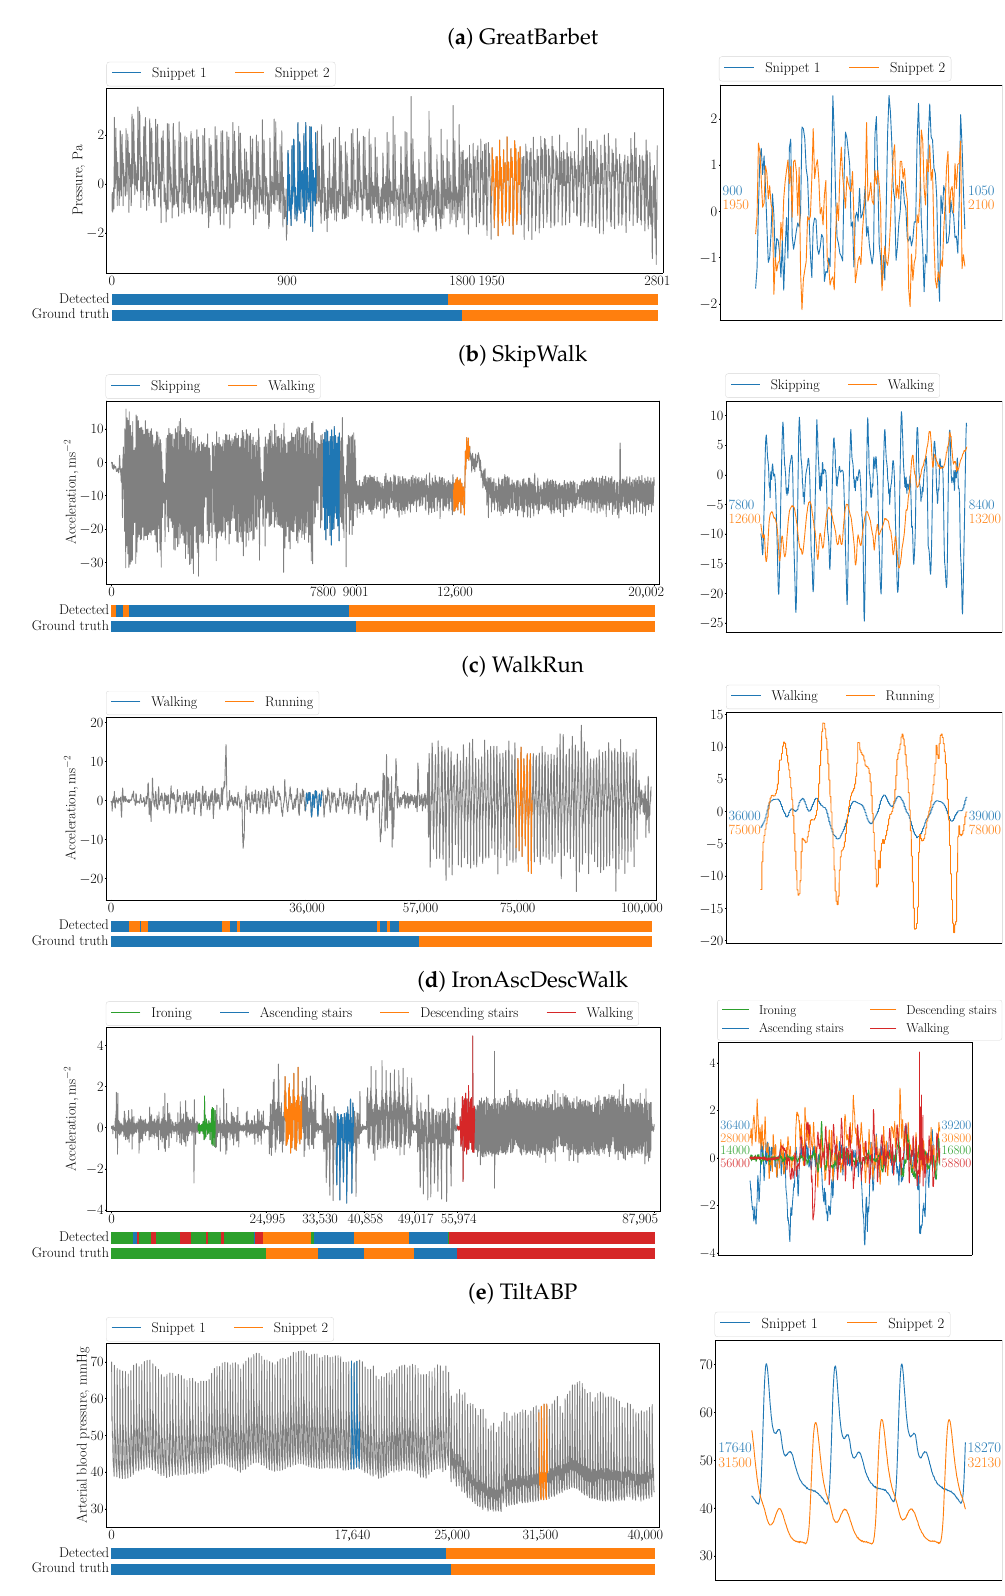
Figure 6. Summarization of time series with the PSF algorithm (left: top—time series where snippets are colored, bottom—ground truth labeling and this one detected through the snippets; right: the snippets found including their start and end